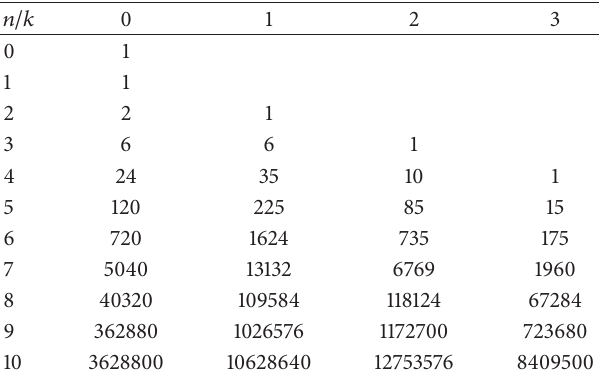
Table 1: Values of 𝑠 −1 (𝑛,𝑘)